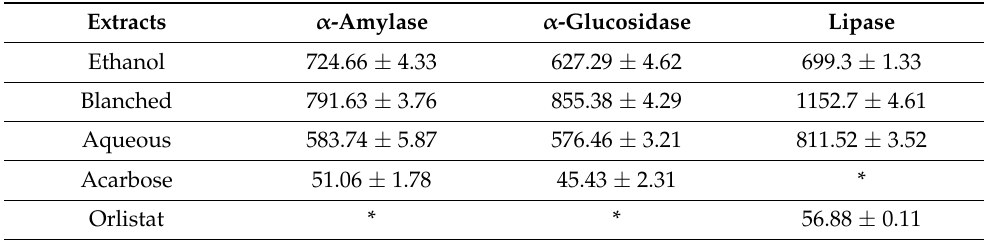
Figure 4. Alpha-amylase inhibitory activity of H. arborescens leaf extracts and positive control (acarbose). Values are mean ± SD ( n = 3). Mean separation by SD ( p < 0.05). Set of bars (the same concentration) with different alphabets are different. Table 1. IC 50 values for α -amylase and α -glucosidase inhibition by H. arborescens leaf extracts and standards ( µ